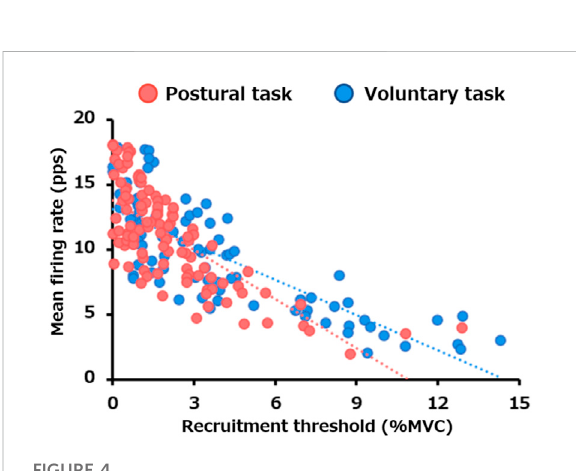
FIGURE 4 Difference in the relationship between the recruitment threshold and mean fi ring rate between the two motor tasks. The scatter plot presents the relationship between the recruitment thresholds and mean fi ring rates for all motor units pooled from all participants in the postural (red) and voluntary (blue)